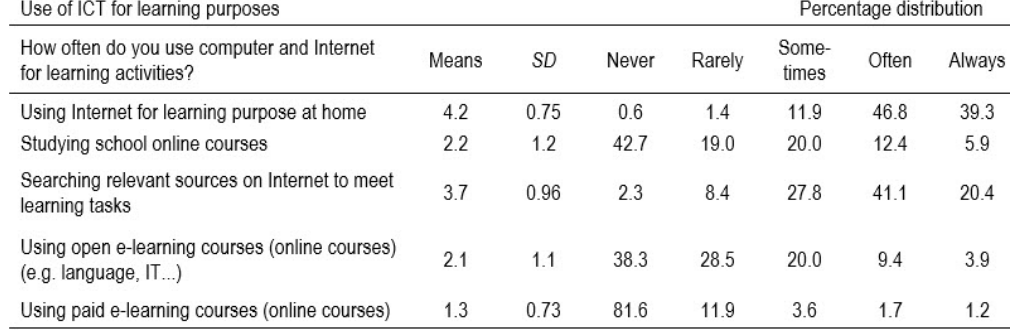
Use of ICT for learning purposes (means, standard deviations, and percentage distributions, n =